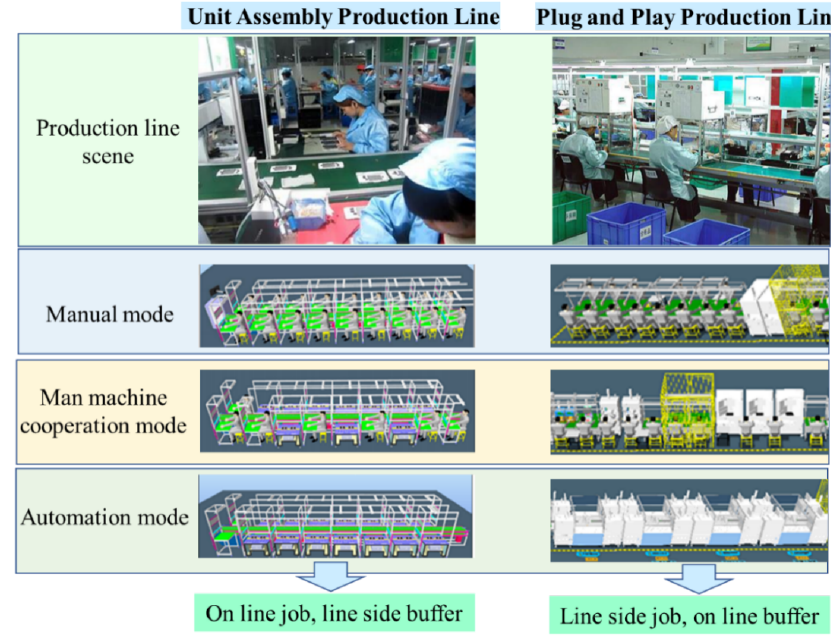
Figure 3. Comparison of two production line architecture